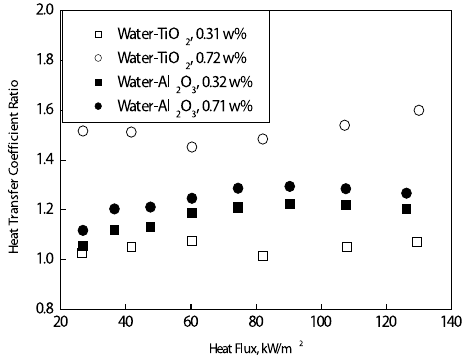
Fig. 10 Heat flux as a function of the wall superheat. Fig. 11 Heat transfer coefficient ratio as a function of heat